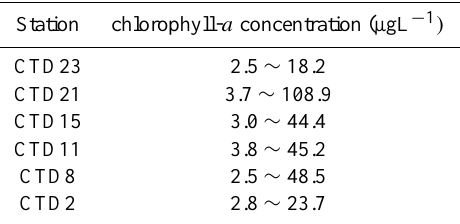
Table 3. chlorophyll- a concentration in the Sumjin River Estuary (Park et al.,